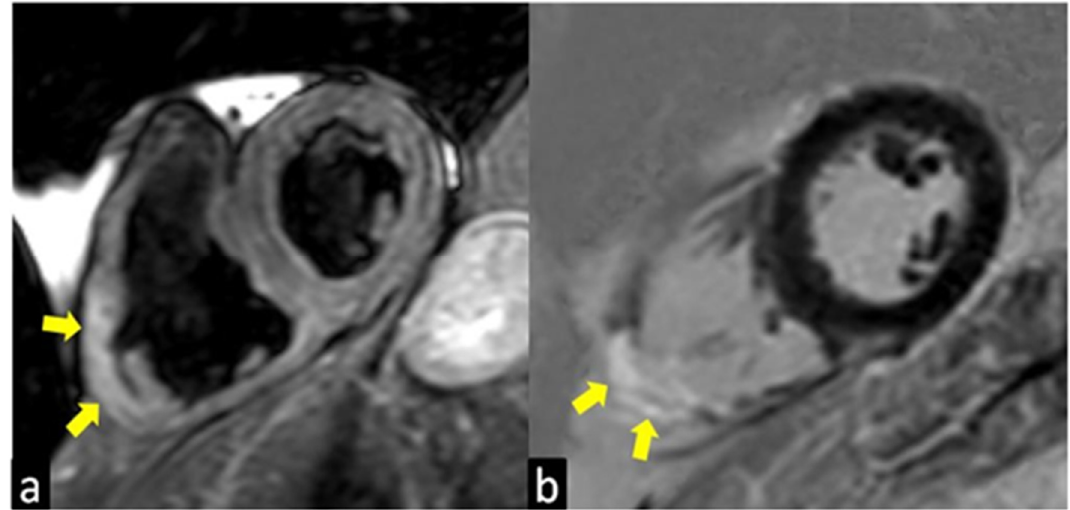
Figure 2. T2-weighted ( a ) and Late Gadolinium Enhancement (LGE; b ) images show a case of atypical presentation of the acute phase of Cardiac Sarcoidosis, characterized by the presence of edema (yellow arrow in a ) and LGE (yellow arrow in b ) of the inferolateral wall of the right ventricle with the transmural